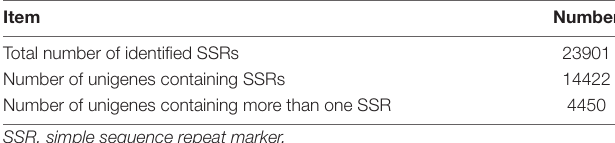
TABLE 3 | Occurrence of SSRs in the surveyed elongate loach transcriptome.